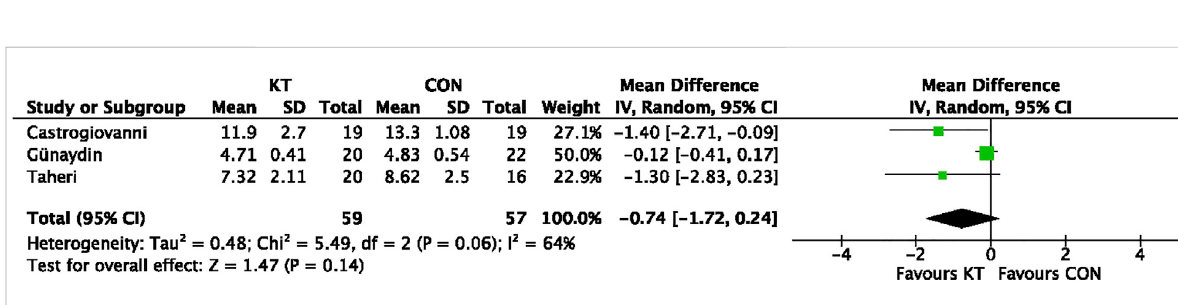
FIGURE 8 Forest plot of the meta-analyses comparing the KT group with control group for TUG score after